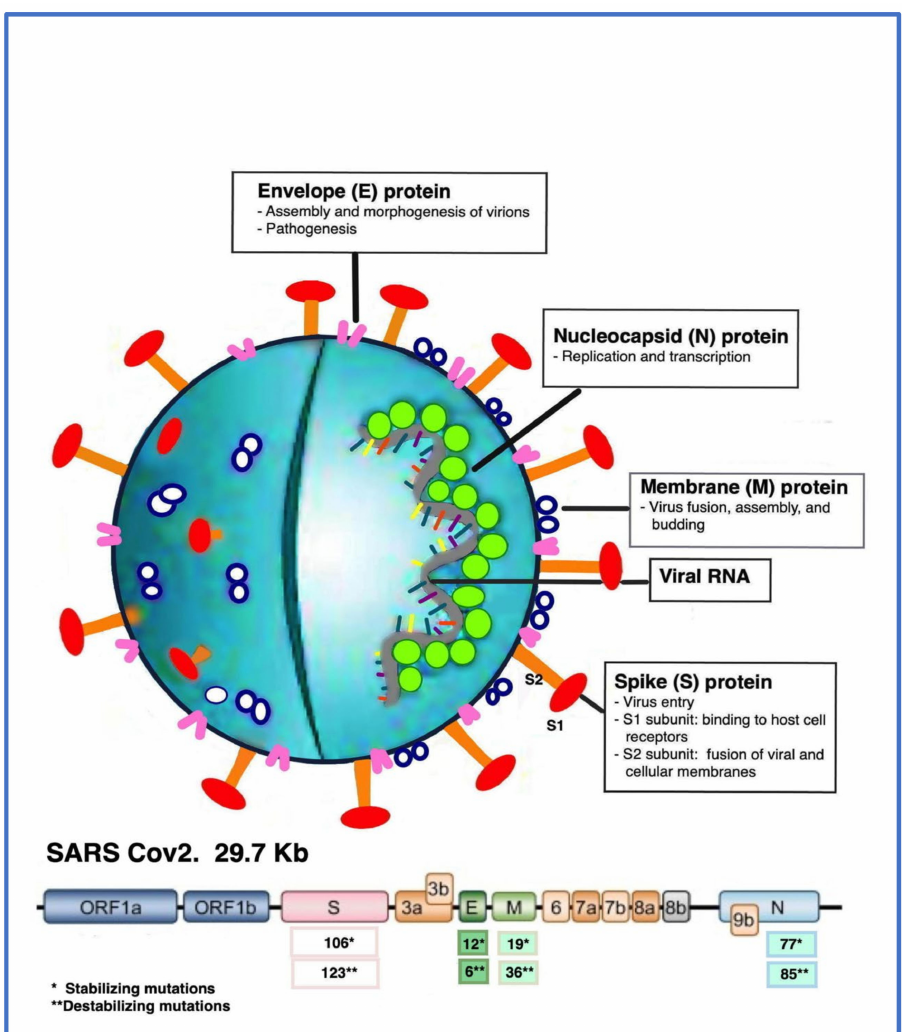
Figure 1. Schematic representation of structure and genome of SARS-CoV-2. The single-stranded RNA (ssRNA) of 29.7 Kb, with nucleocapsid (N) proteins, is covered with the envelope (E) and mem- brane (M) proteins, whereas the spike (S) proteins are located on the outside of the viral particle. The genome is also characterized by the presence of ORFs 1a and 1b, encoding nonstructural polyproteins (NSPs), and ORFs 3a, 3b, 6, 7a, 7b, 8a, 8b, and 9b, encoding accessory proteins. The main functions of structural proteins are also indicated as follows: E protein—virion assembly, morphogenesis, and pathogenesis; N protein—genome replication and transcription; M protein—virion fusion, assembly, and budding; S protein—virus entry, with S1 subunit binding to host cell receptors (RBDs) and S2 subunit fusing viral and cellular membranes. The numbers of stabilizing and destabilizing mutations identified in the different structural proteins of SARS-CoV-2 are also